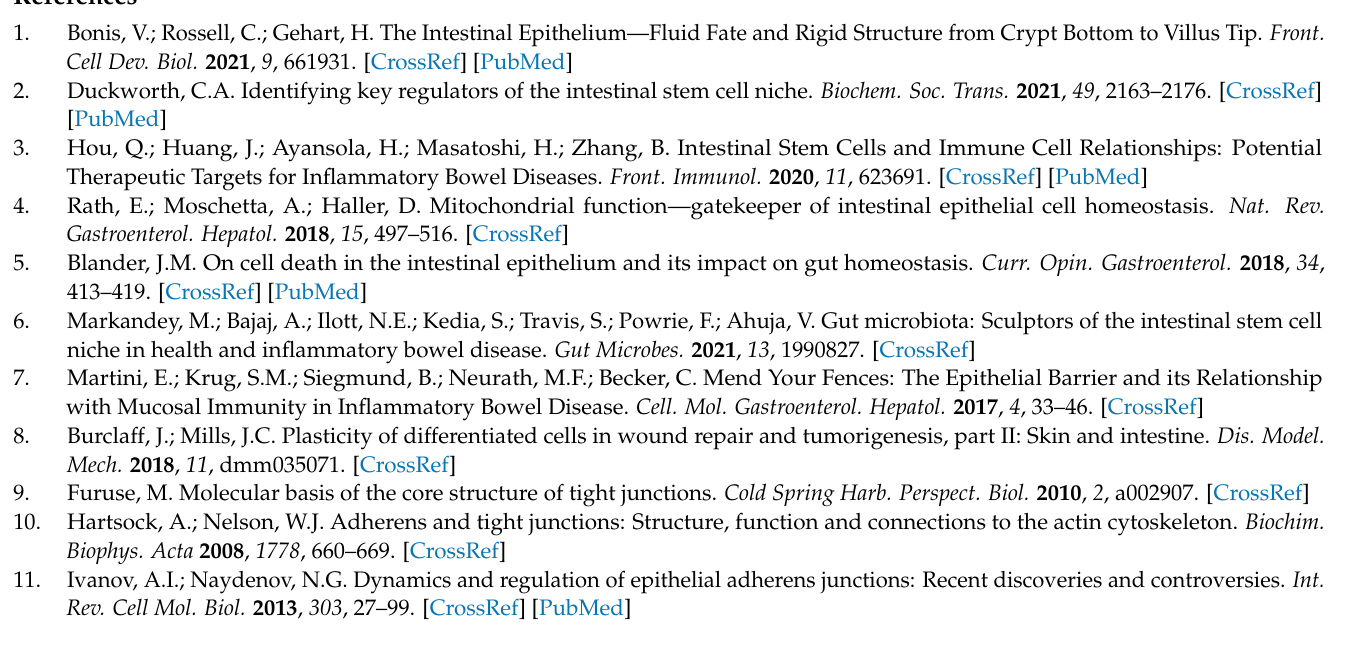
adhesions; Figure S7: Expression of AJ and TJ proteins in control and P-cadherin-deficient IEC; Figure S8: Inhibition of NM-II reverses the accelerated wound healing in P-cadherin-deficient IEC monolayers; Figure S9: Enrichment map showing pathways upregulated in P-cadherin knockout HCA-7 cells; Table S1: Top 30 upregulated genes in P-cadherin knockout HCA-7 cells; Table S2: Top 30 downregulated genes in P-cadherin knockout HCA-7 cells; Movie S1: Live cell imaging of wound healing in control HCA-7 cell monolayers; Movie S2: Live cell imaging of wound healing in P-cadherin knockout (sgRNA1) HCA-7 cell